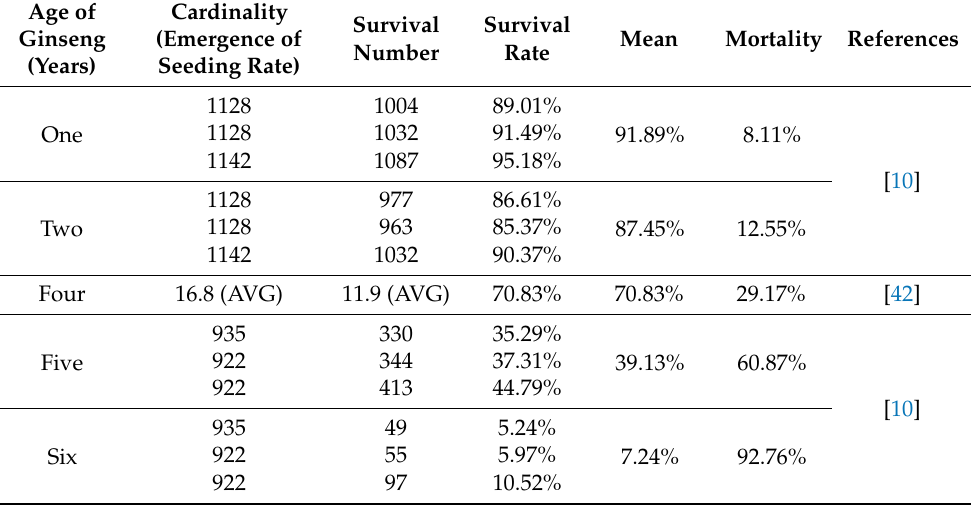
Table 3. Data investigation on the seedling survival rate of ginseng plants of five